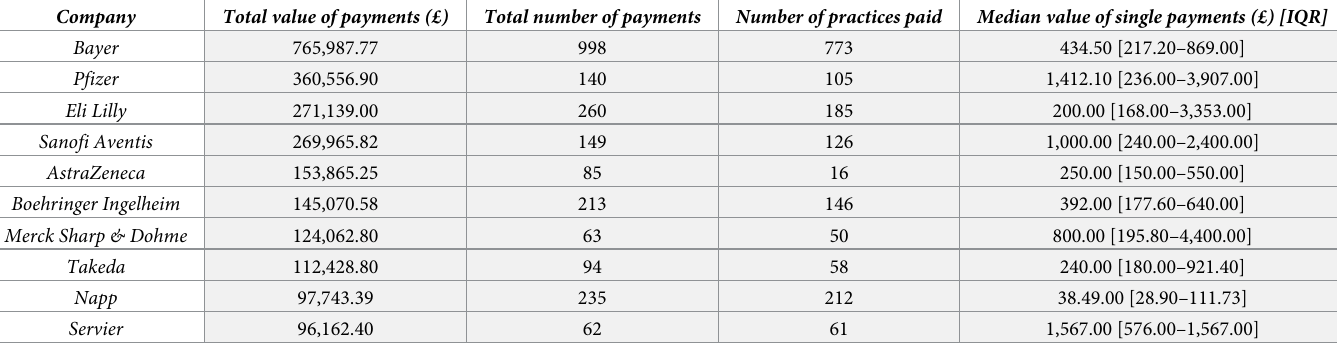
Table 2. Payments made by the top 10 drug company donors to general